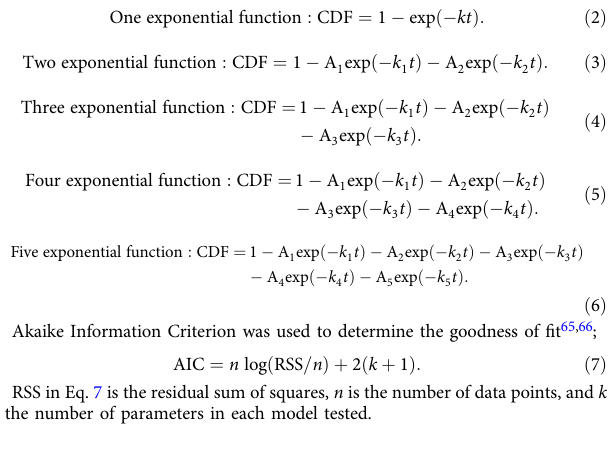
Fig. 4. CDFs generated from the closed- and open-state dwell times provided kinetics for the pore opening and pore closure, respectively. Exponential equations used to fi t the CDFs are provided